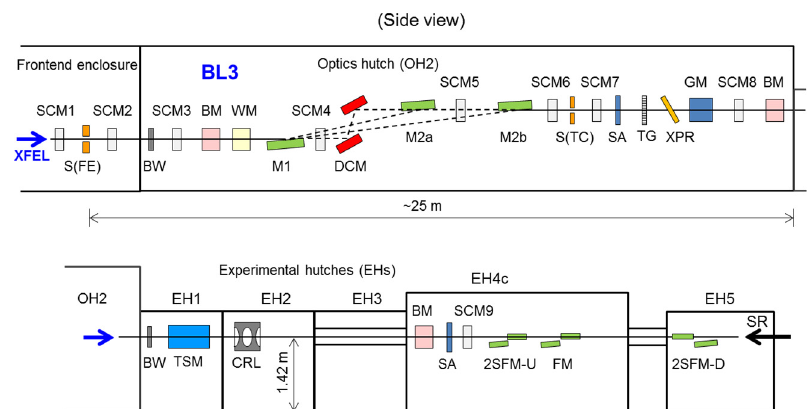
Figure 2. Major optical and diagnostic systems of SACLA BL3. SCM: screen monitor; S(FE): frontend slit; BW: beryllium window; BM: beam intensity and position monitor; WM: wavelength monitor; M1, M2a, M2b: plane mirrors; DCM: double crystal monochromator; S(TC): transport-channel slit; SA: solid attenuator; TG: transmission grating; XPR: X-ray phase retarder; GM: gas intensity monitor; TSM: timing and spectrum monitor; CRL: compound refractive lens; 2SFM-U(-D): two-stage focusing mirrors on the upstream (downstream) side (50 nm spot size); FM: focusing mirrors (1 µm spot size); SR: synchrotron radiation from SPring-8.